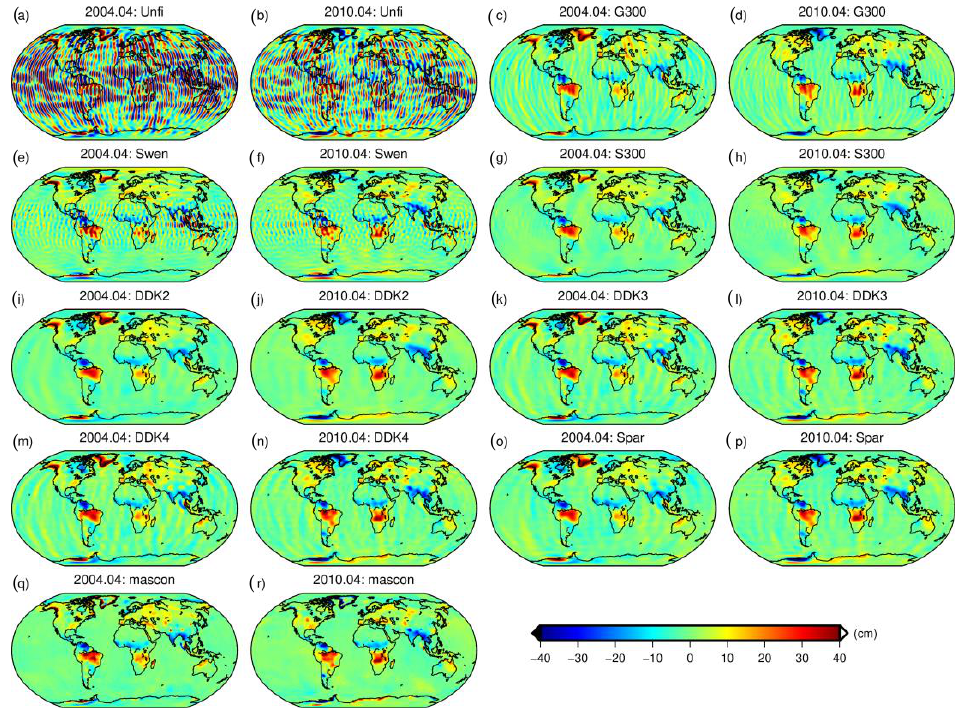
Figure 4. The filtered monthly solutions (in terms of EWH) of 7 filters for April 2004 (the first and the third column) and April 2010 (the second and the fourth column). The solutions before filtering (the first row) and CSR RL06 mascon solutions (the fifth row) are also presented for comparison.